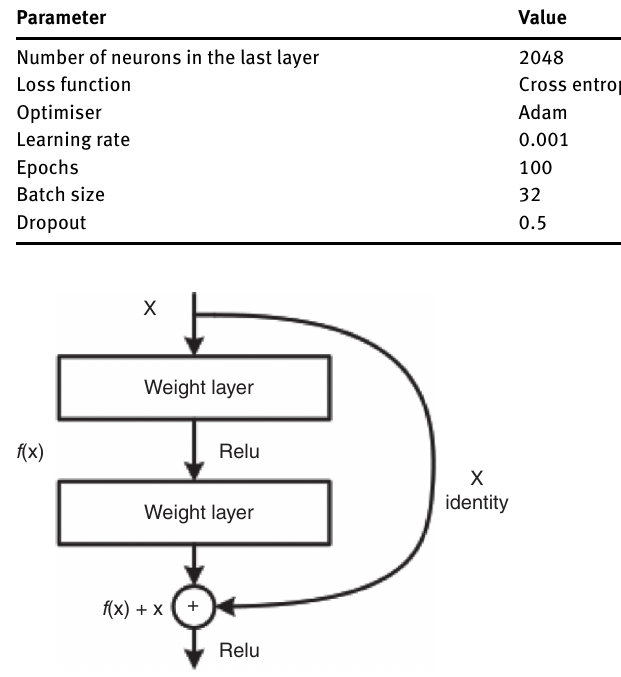
Figure 4: Skip Connection Typically Used in Residual